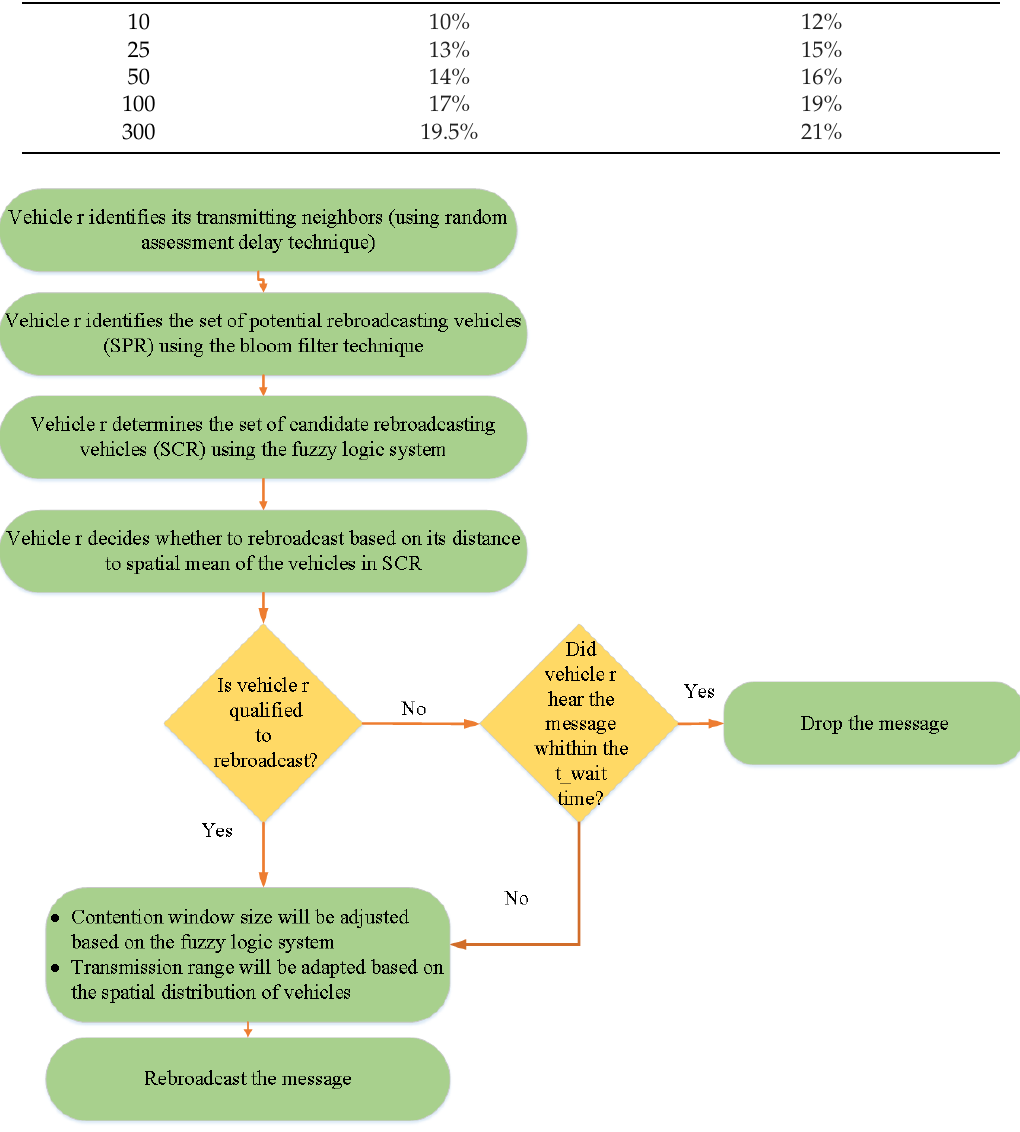
Figure 8. TRAB system